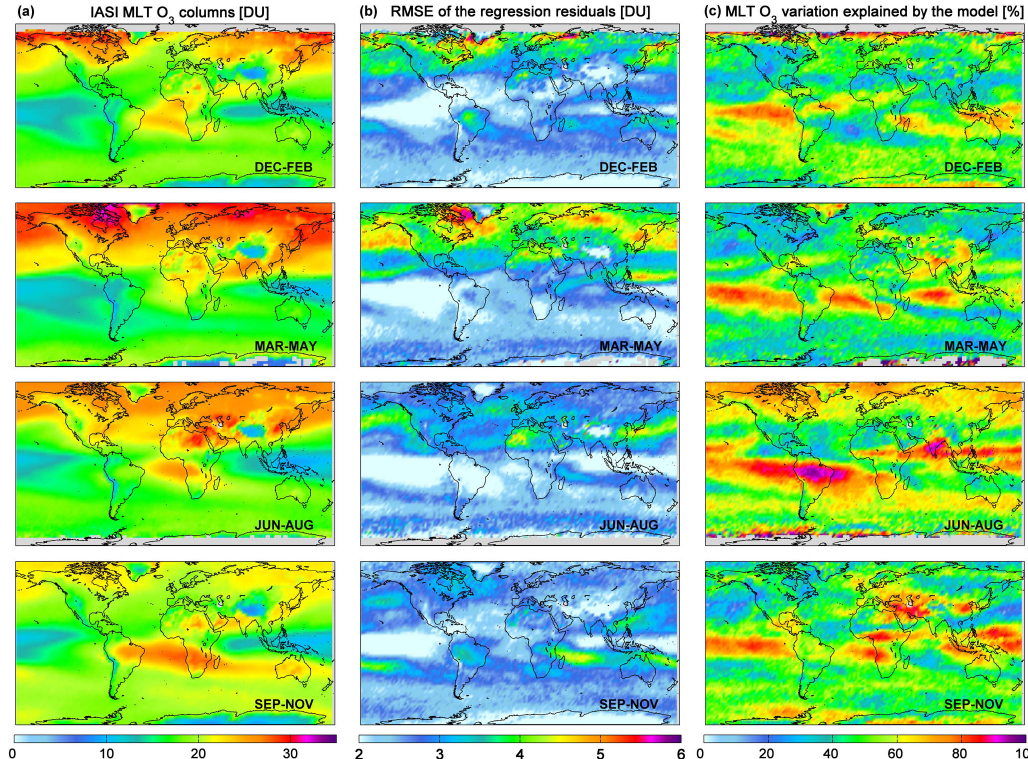
Figure 1. Seasonal distribution of O 3 tropospheric columns (in DU, integrated from ground to 300hPa) measured by IASI and averaged over January 2008–May 2017 (a) , of the RMSE of the regression fits (in DU, b ) and of the fraction of the variation in IASI data explained by the regression model, calculated as 100 ×